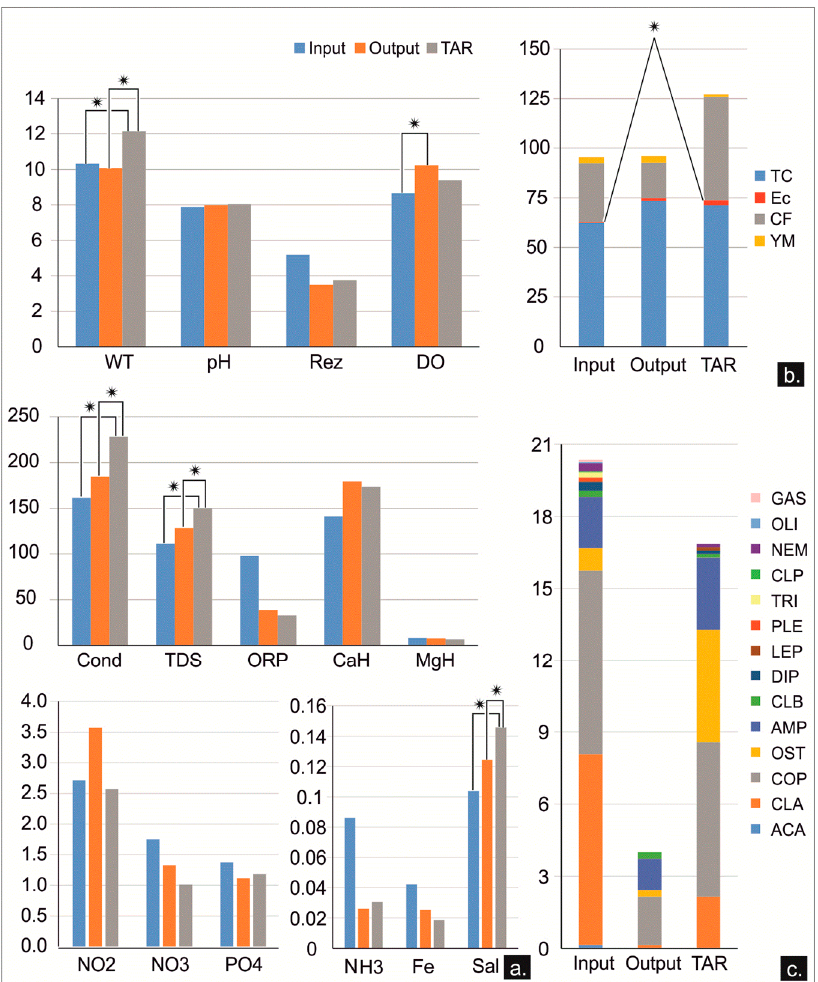
Figure 9. Differences between inputs and outputs of the KSRP freshwater sources, expressed as averages of the values recorded during the 2019–2021 sampling campaigns: ( a ) physicochemical features; ( b ) microbiological content; ( c ) meiofauna presence; * represent significant median differences ( p < 0.05) from the Wilcoxon test.